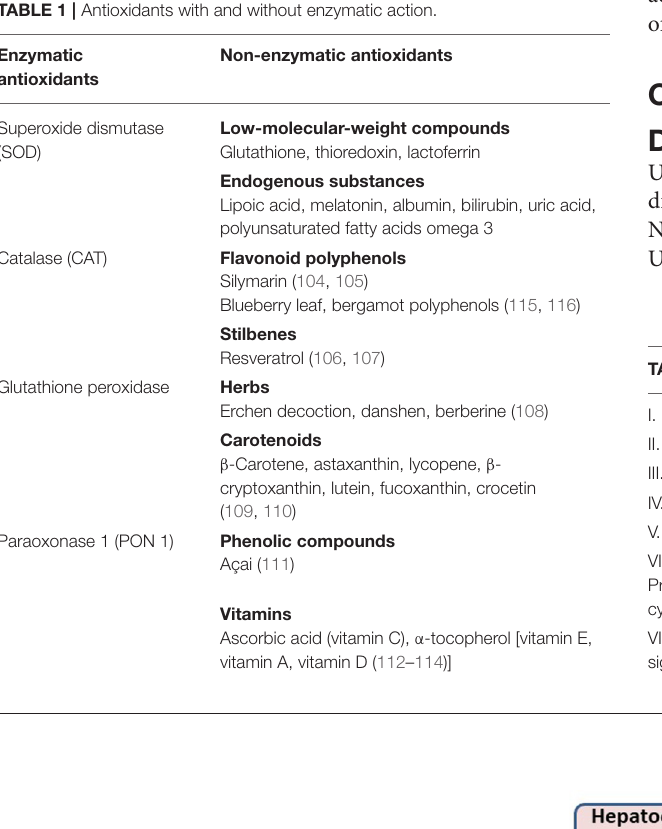
TABLE 1 | Antioxidants with and without enzymatic action.